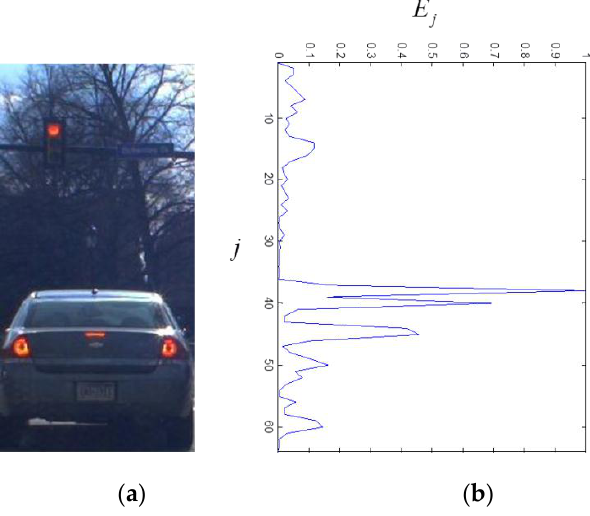
Figure 8. The result of the horizontal edge: ( a ) is the hypothesized window; and ( b ) is the horizontal edge in terms of j .